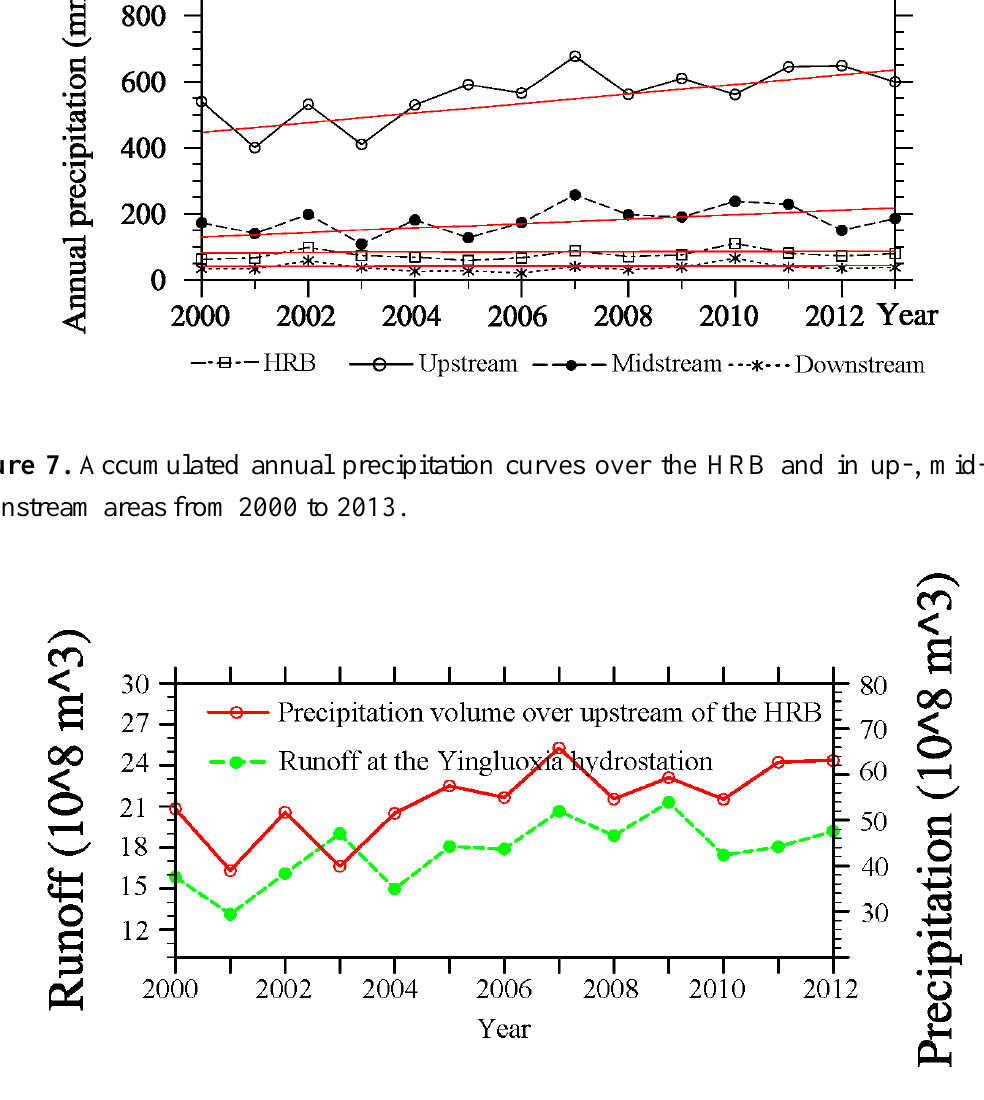
Figure 8. Annual runoff curve at the Yingluo Valley from 2000 to